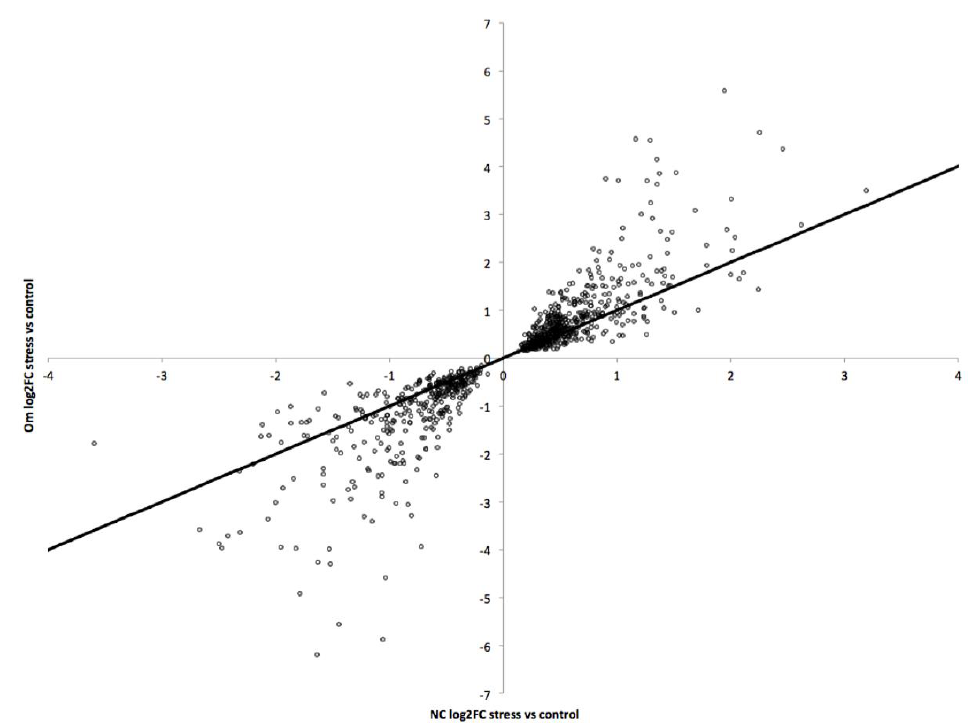
Figure 6 . Scatterplot of the log2-fold changes in gene expression in response to heat stress in the Om colonies (y-axis) vs. the NC colonies (x-axis) for the 848 genes that were over-expressed (498 genes) or under-expressed (350 genes) in colonies from both localities. The line represents the y=x line depicting similar responses between